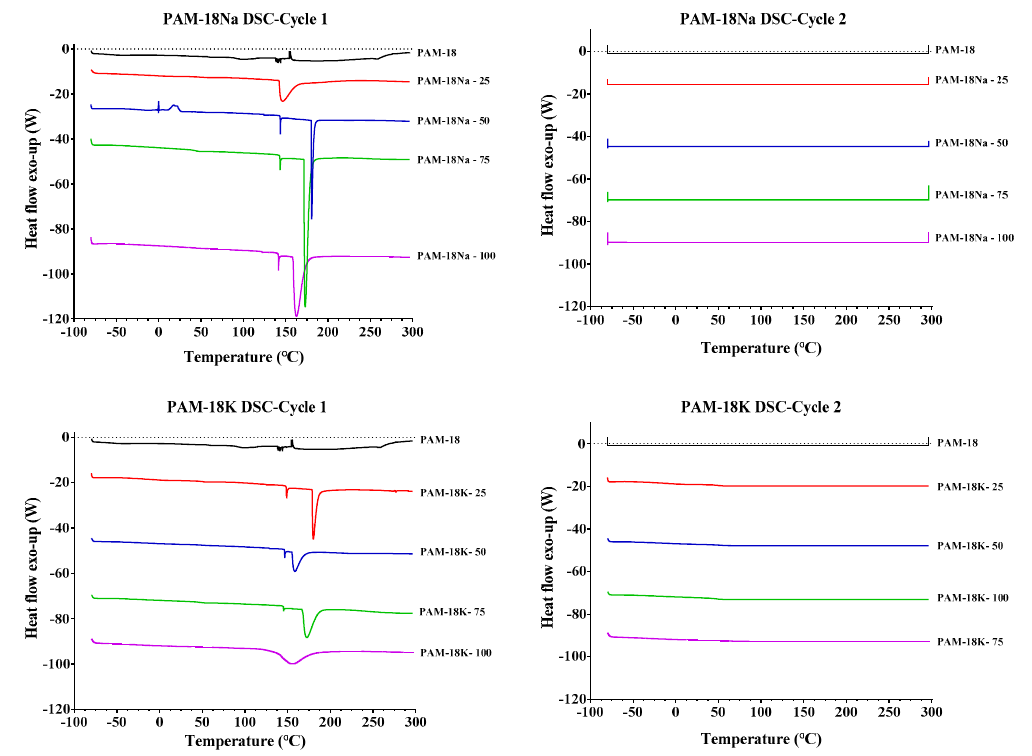
Figure 5. Differential Scanning Calorimetry (DSC) of polymers derived from PAM-18.